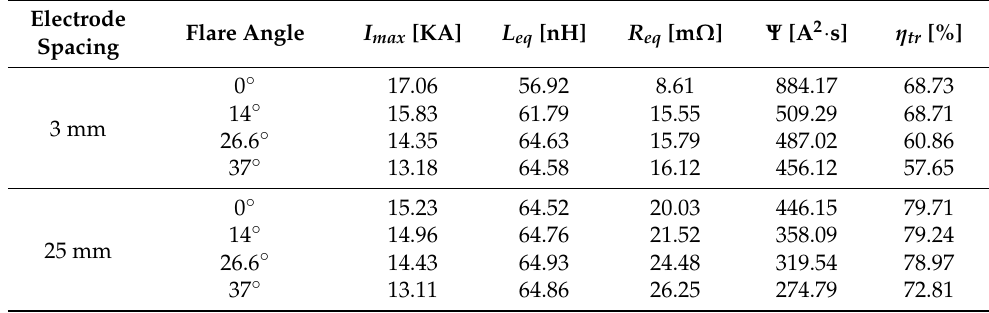
Table 1. The APPT discharge circuit parameters with the rectangular electrode with different flare angles.